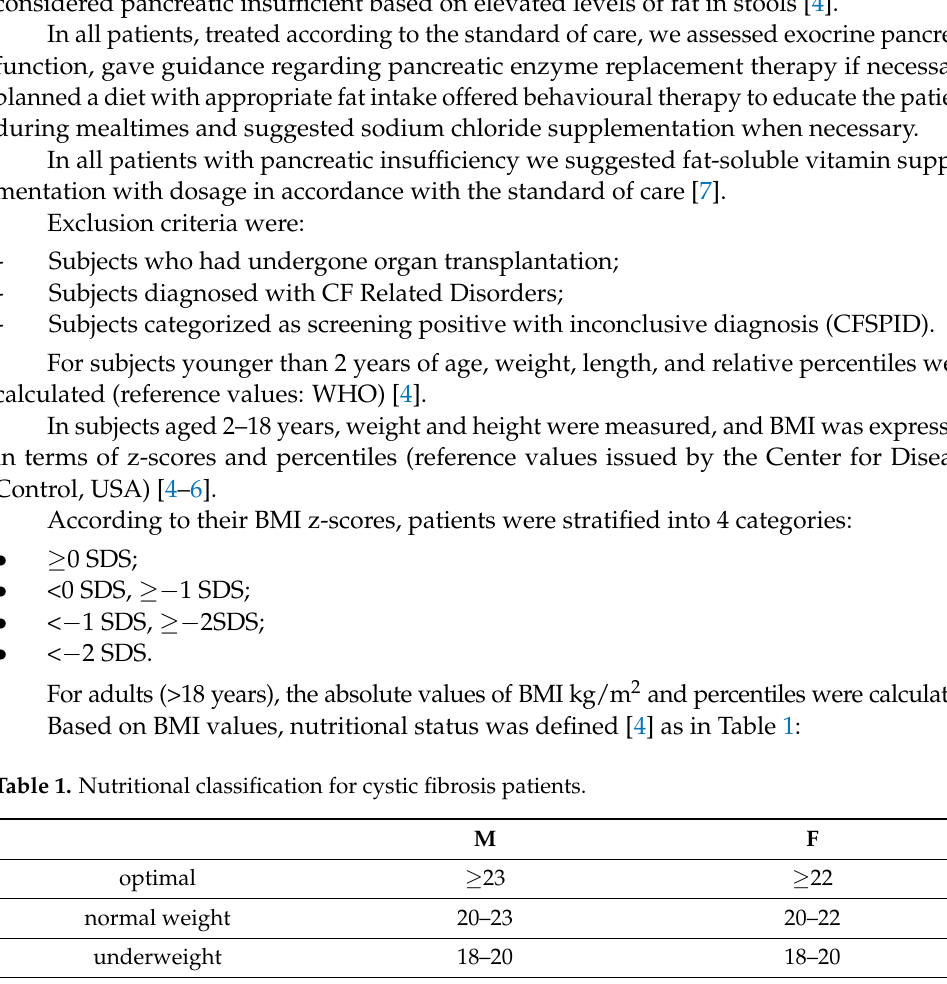
optimal ≥ 23 ≥ 22 normal weight underweight malnutrition